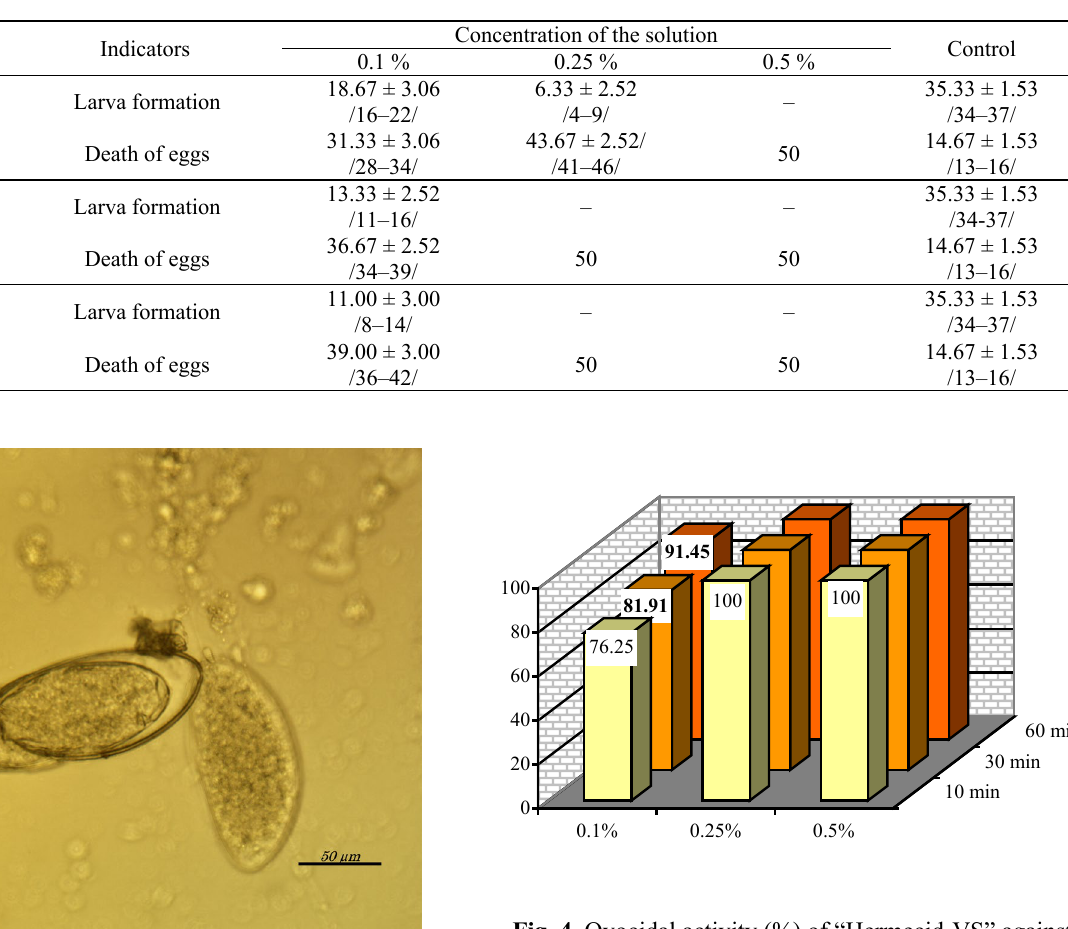
Fig. 2. Destruction of the shell in the egg of Passalurus ambiguus at the zygote stage with the use of “Virosan”